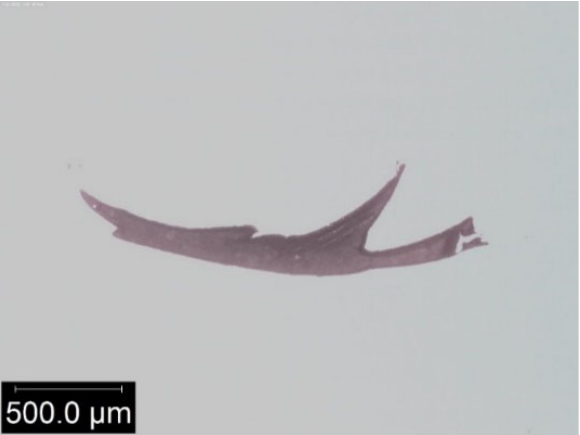
Figure 7. An example of defect size produced in this study. This cross section was made from a weld that was produced with parameter set 6 from Table 1.